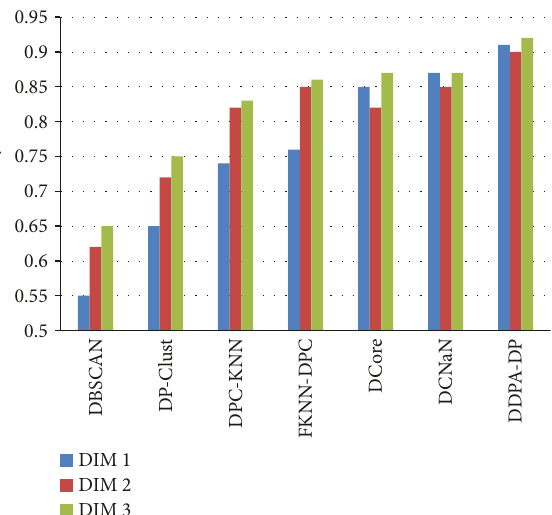
Figure 21: The simulation results in GL